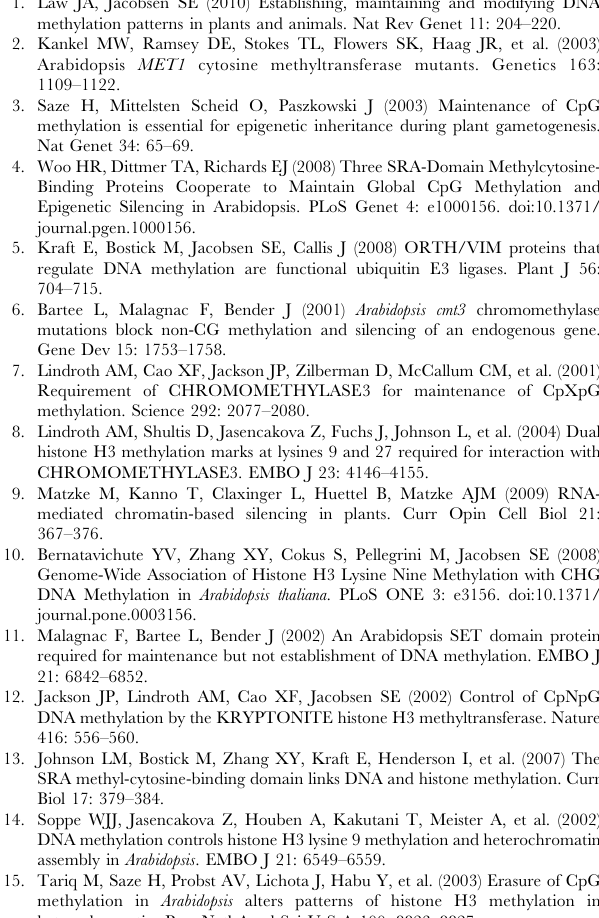
Table S1 Crystallographic data collection and refinement Table S2 List for primers and probes used for